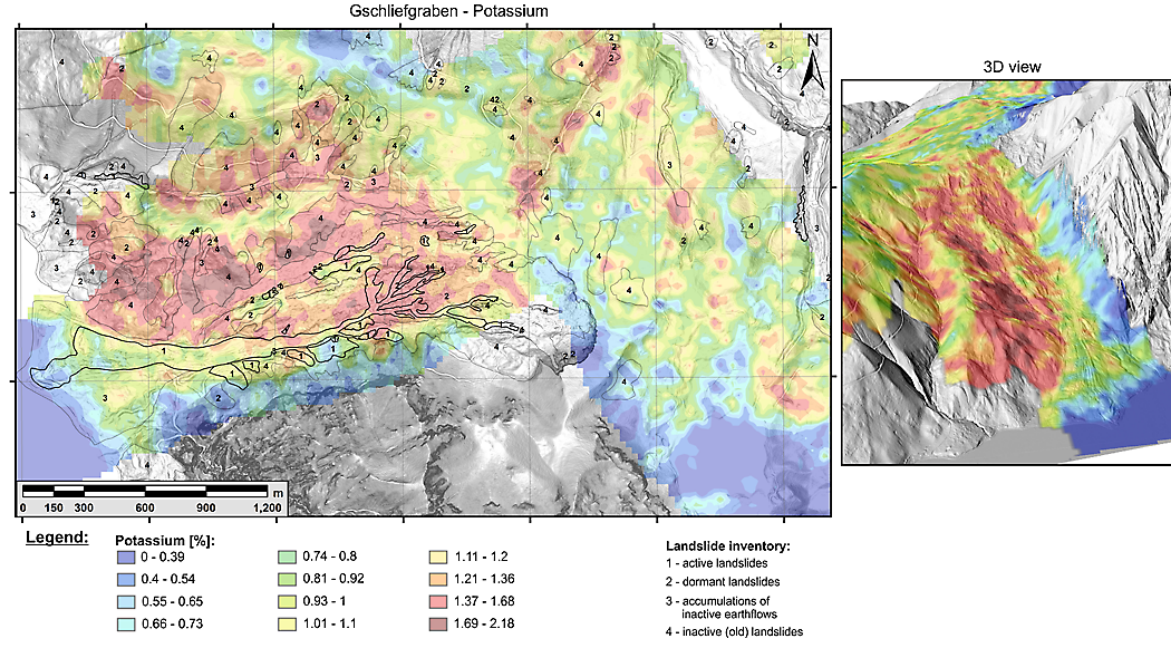
Fig. 11. Map of the potassium content at the ground surface compared to the landslide inventory map; right side: 3-D view from the west.